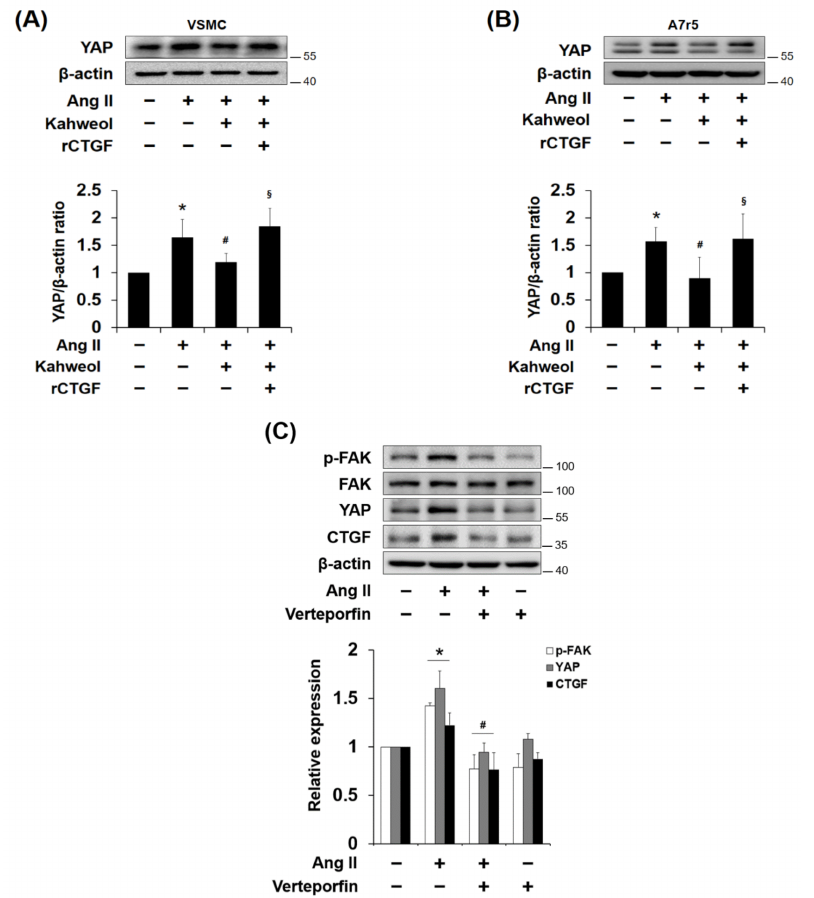
Figure 6. The involvement of Yes-associated protein (YAP) in the regulatory effect of kahweol in Ang II-stimulated VSMCs. ( A , B ) Cells were pretreated with rCTGF and kahweol at one hour intervals and then stimulated with Ang II for 24 h. Protein levels of YAP and β -actin were determined by Western blotting with specific antibodies. Bar graphs present the densitometric quantification of the Western blot bands. ( C ) Cells were pretreated with verteporfin (100 nM) for one hour and then treated with Ang II (100 nM) for 24 h. Protein levels of phosphorylated FAK, YAP, CTGF and β -actin were determined by Western blotting with specific antibodies. Bar graphs present the densitometric quantification of the Western blot bands. Results are representative of three independent experiments. *, p < 0.05 vs. untreated control; #, p < 0.05 vs. Ang II group; §, p < 0.05 vs. kahweol + Ang II treated